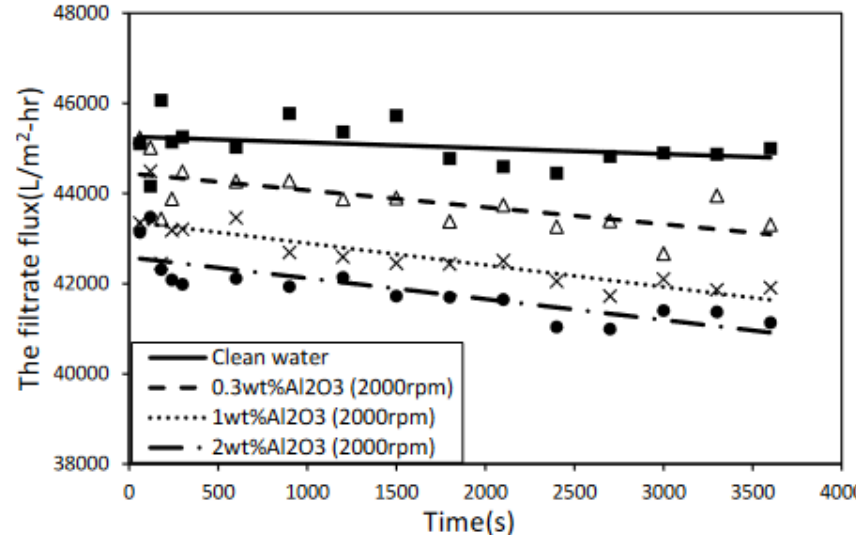
Figure 9. Filtrate flux rate at different concentrations of slurry.